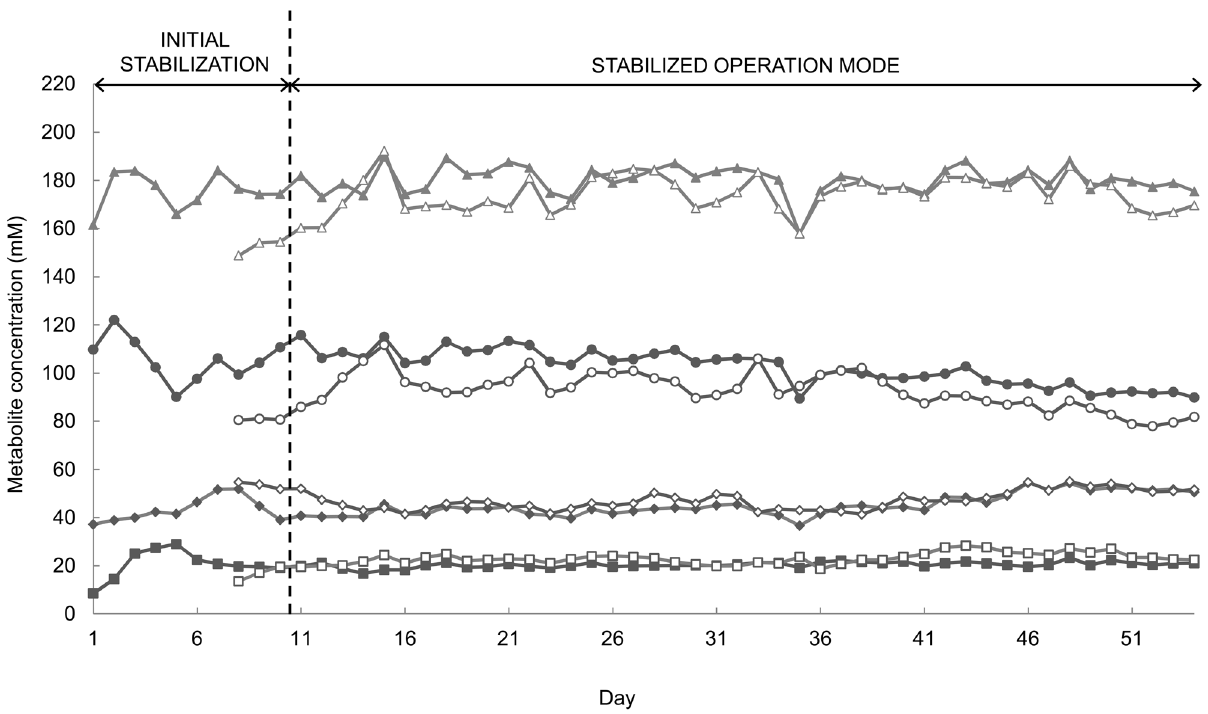
N , # ) acetate, ( ¤ , e ) propionate,